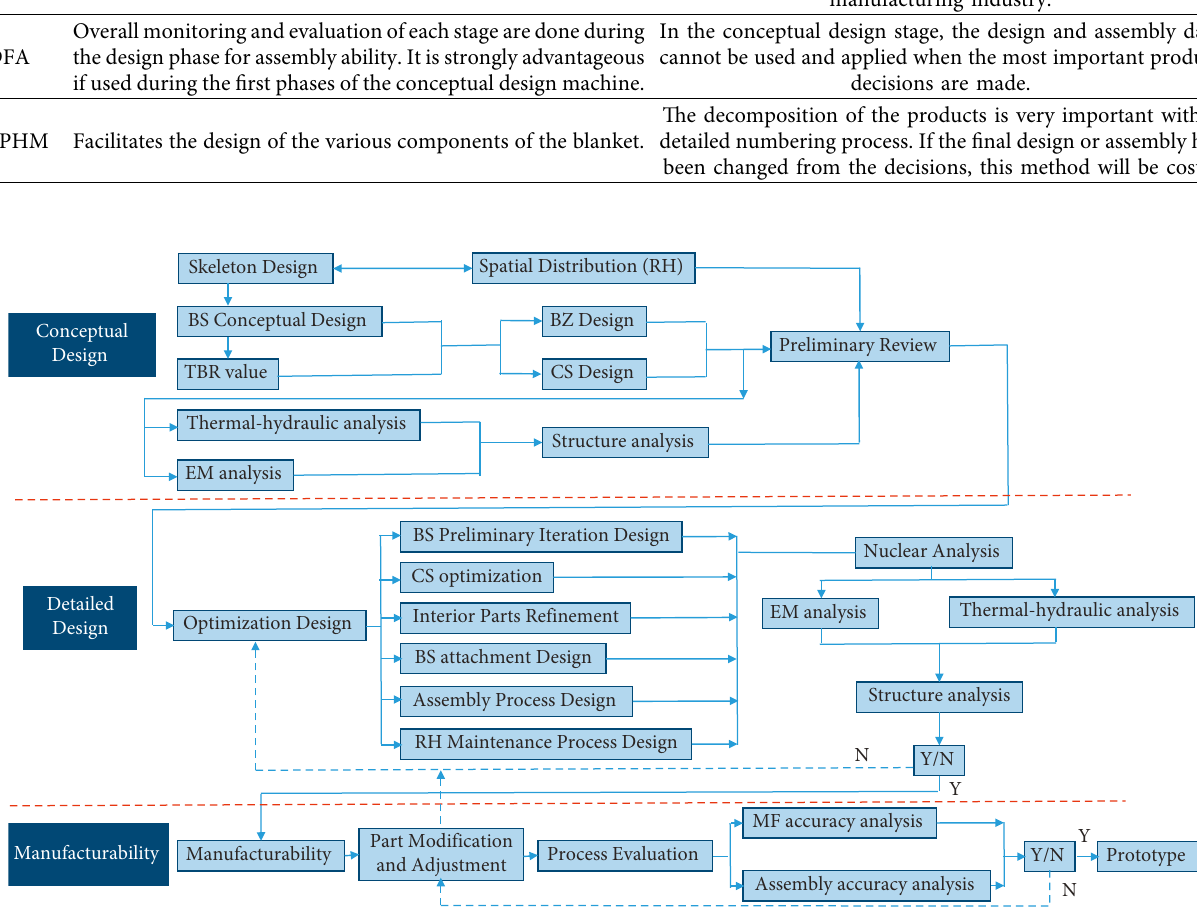
Figure 2: An approach for the blanket system assembly flow